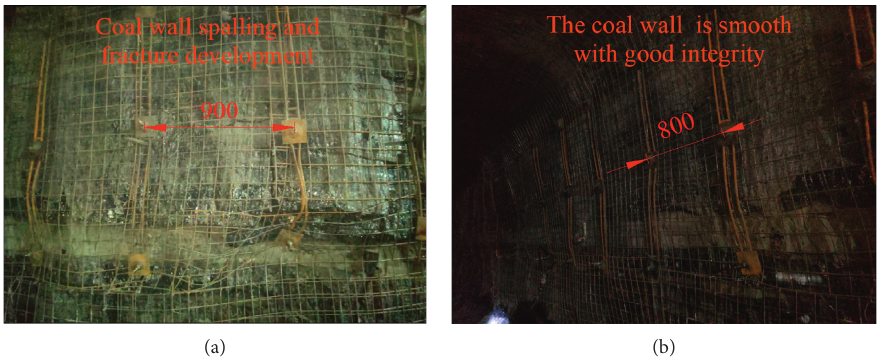
Figure 17: Comparison of roadway formation with different support parameters. (a) Support spacing of 900mm × 900 mm. (b) Support spacing of 900mm × 800mm.